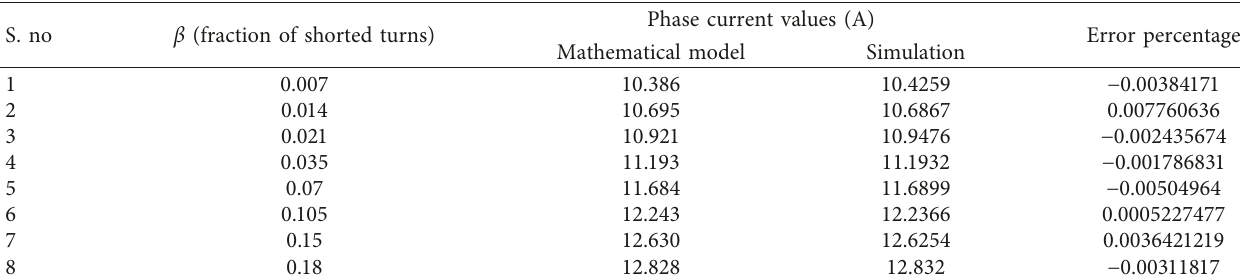
Table 3: Comparison of phase current values of 5hp motor obtained from experiment and mathematical